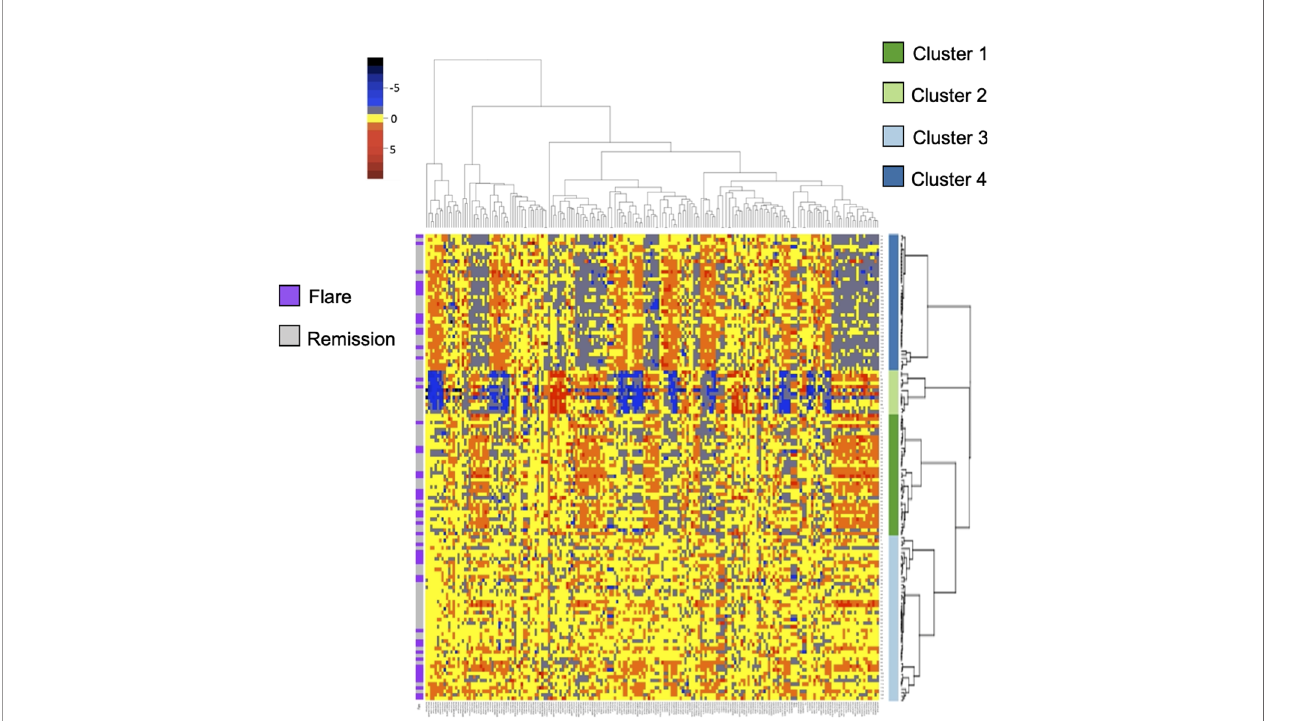
FIGURE 1 | Heatmap and hierarchical clustering of 200 serum proteins in stable RA. Protein expression is scaled and colored by relative expression. Each column is a protein and each row is a patient. Clustering is shown in both dimensions. Flare or remission is annotated in purple or grey to the left of the